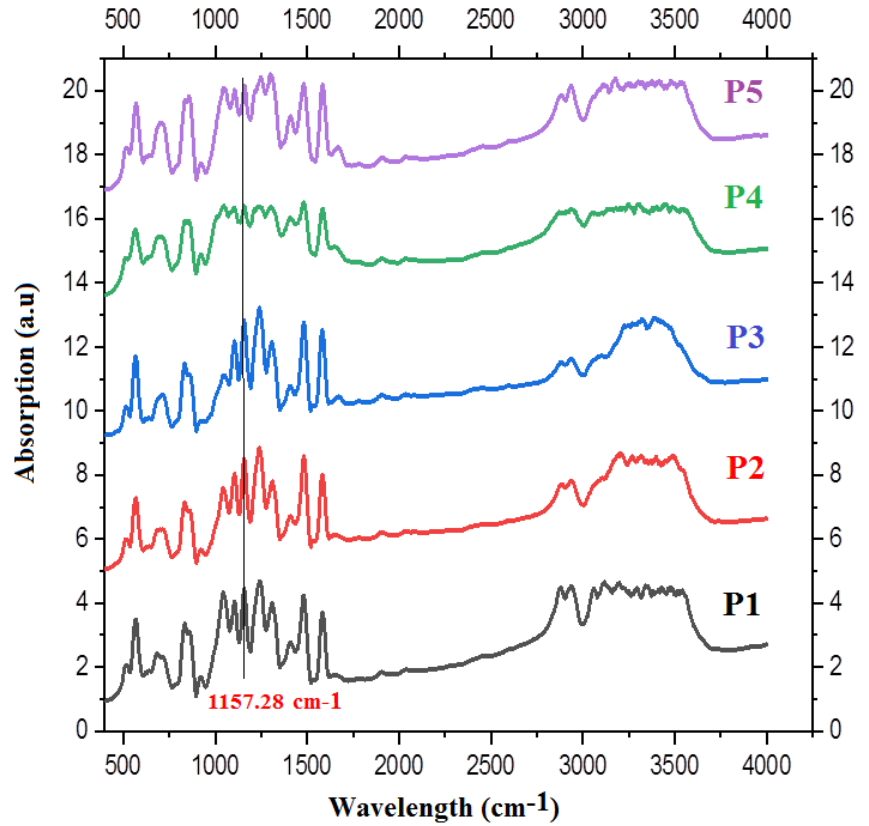
Figure 2. Fourier-Transform Infrared (FTIR) Spectroscopy of PPSU and PPSU-PES membranes at various PES contents.